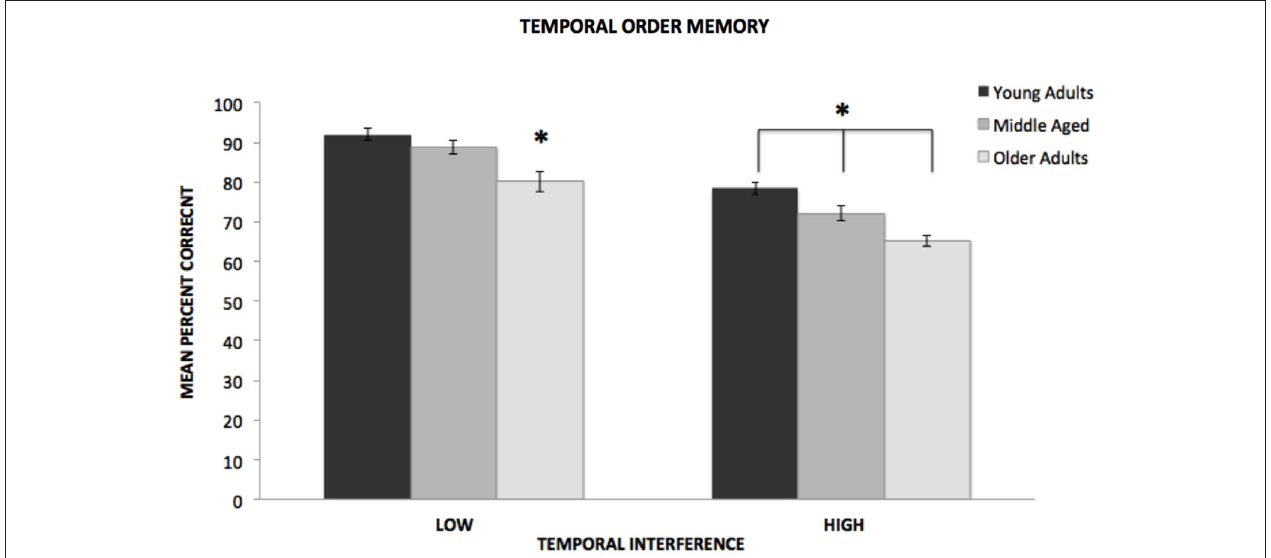
FIGURE 1 | Mean percent correct responses for young, middle-aged, and older adults on low and high temporal interference trials of the temporal order memory task . *Indicates significance difference of p < 0.001.